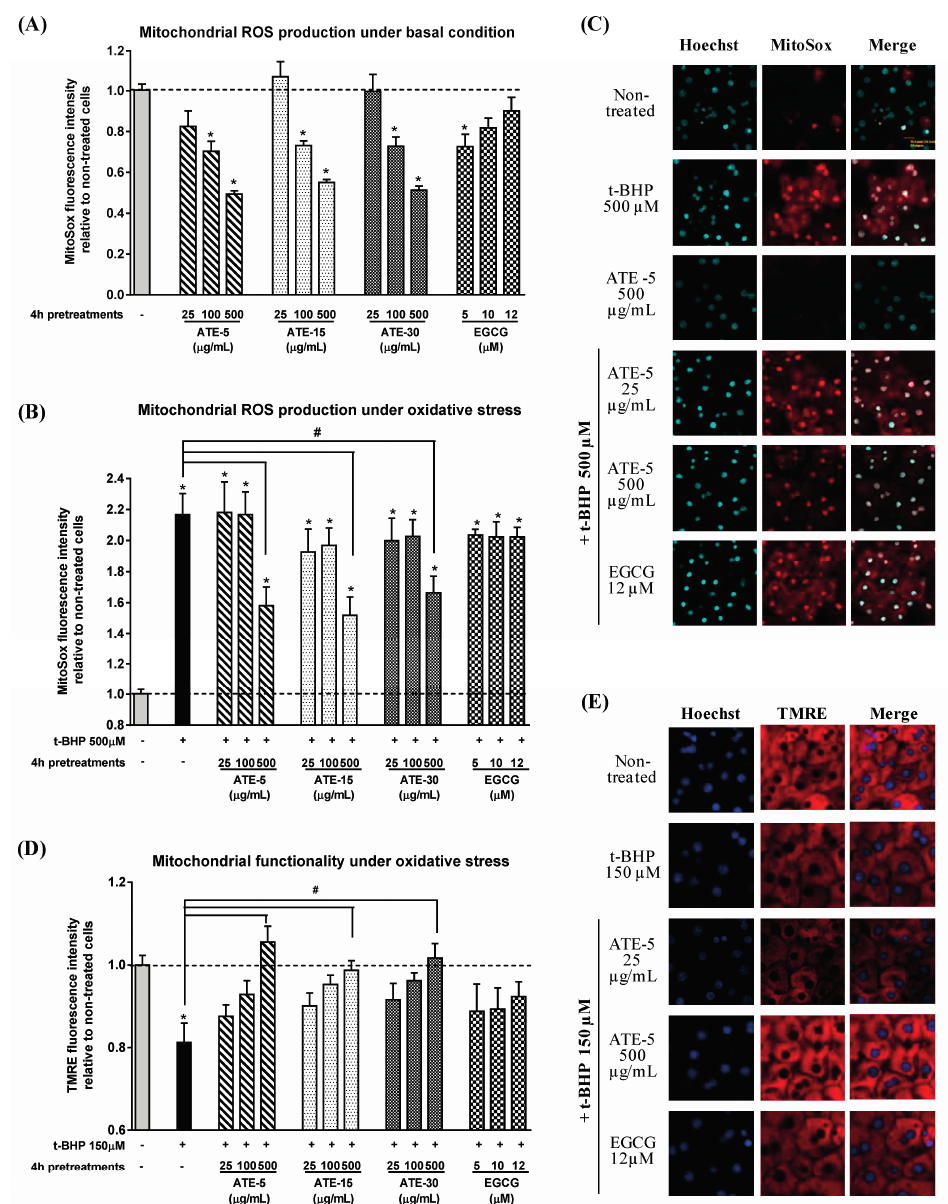
Figure 4. Effect of ATE or EGCG on mitochondrial superoxide anion (O 2 − ) production and on mitochondrial functionality. Cells were seeded onto 96-well E-plates, pretreated for 4 h with various concentrations of tea extracts (25, 100 and 500 µg/mL) or EGCG (5, 10 and 12 µM), then treated for 1 h with t -BHP at 150 µM. Cells were labeled with Hoechst 33342 and MitoSox ( A – C ) or TMRE ( D , E ) for 30 min before being read on the ArrayScanXTI. Mitochondrial superoxide (O 2 − ) content ( A , B ) was calculated from the MitoSox fluorescence intensity following the “compartmental analysis protocol”. Mitochondrial functionality ( D ) was calculated from the TMRE fluorescence intensity following the “compartmental analysis protocol”. Error bars indicate the mean ± SEM of triplicate determinations in three independent experiments (note: * p < 0.05 when compared to non-treated cells, # p < 0.05 when compared to non-pretreated + t -BHP treated cells). Objective magnification ×20. General note: − indicates the absence of t -BHP or ATE, and + indicates the presence of t -BHP, in the culture